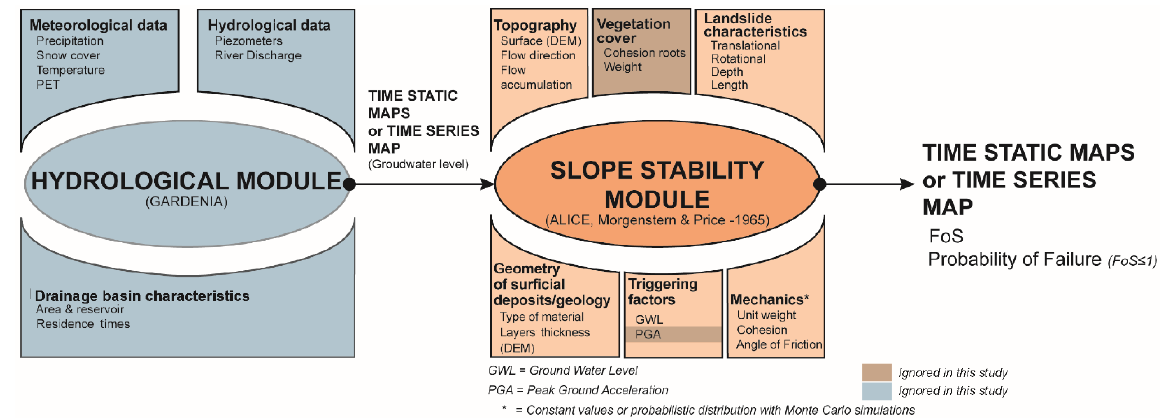
Figure 5. ALICE ® concept (from [69] ).